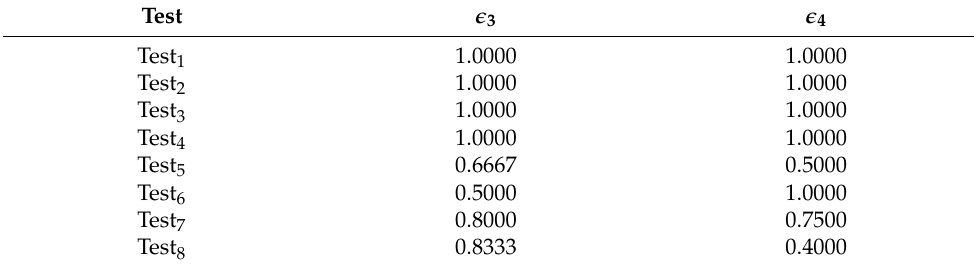
Table 4. String stability